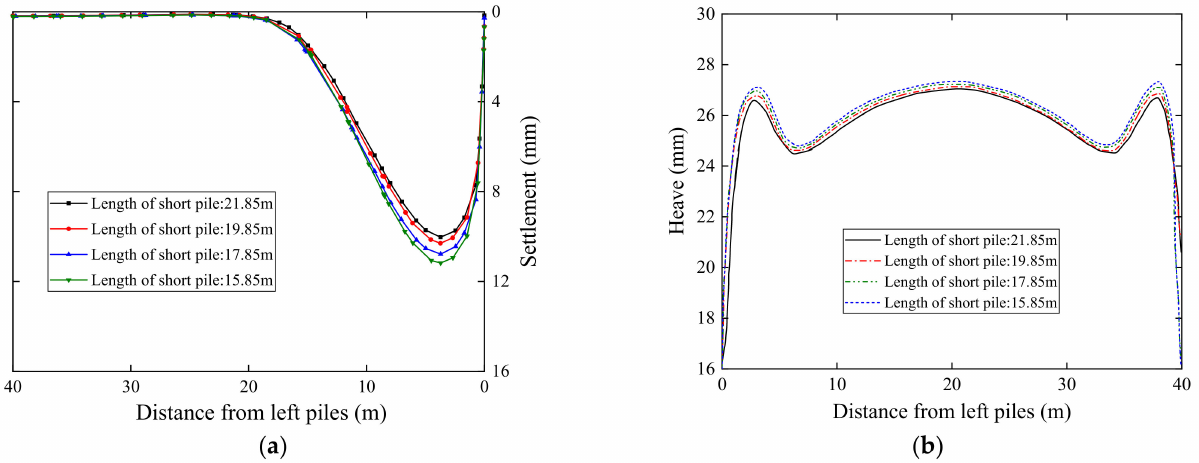
Figure 17. Settlement curve of surface soil and uplift curve of the bottom of excavation: ( a ) surface settlement curve; ( b ) heave